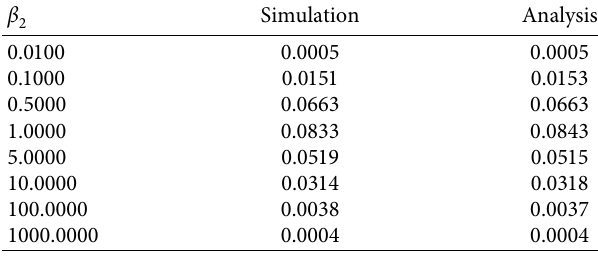
Figure 4: Statistical error versus β